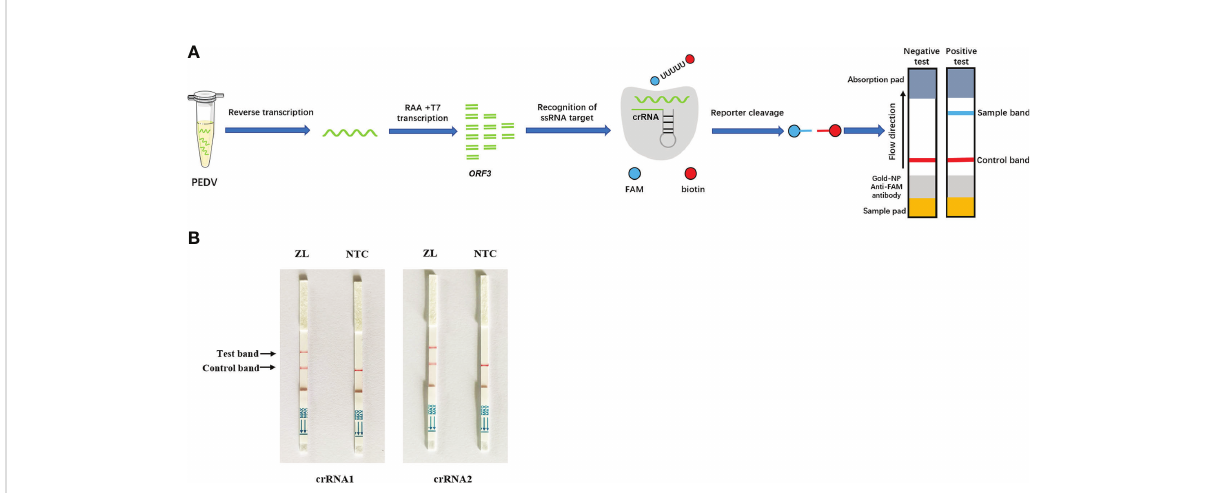
FIGURE 2 Establishment of the CRISPR/Cas13a lateral fl ow detection. (A) Schematic illustration of the work fl ow for Cas13a PEDV testing. The ORF3 gene in the PEDV genome was ampli fi ed by RAA and transcribed into RNA that was recognized by crRNA and activated Cas13a nuclease. The activated Cas13a nuclease then cleaved the reporter molecule, and the reporter molecule could appear as a band on the test strip. (B) Analysis of different crRNAs by CRISPR/Cas13a lateral fl ow detection. ZL, pMD19T-ORF3 standard plasmid and NTC, negative